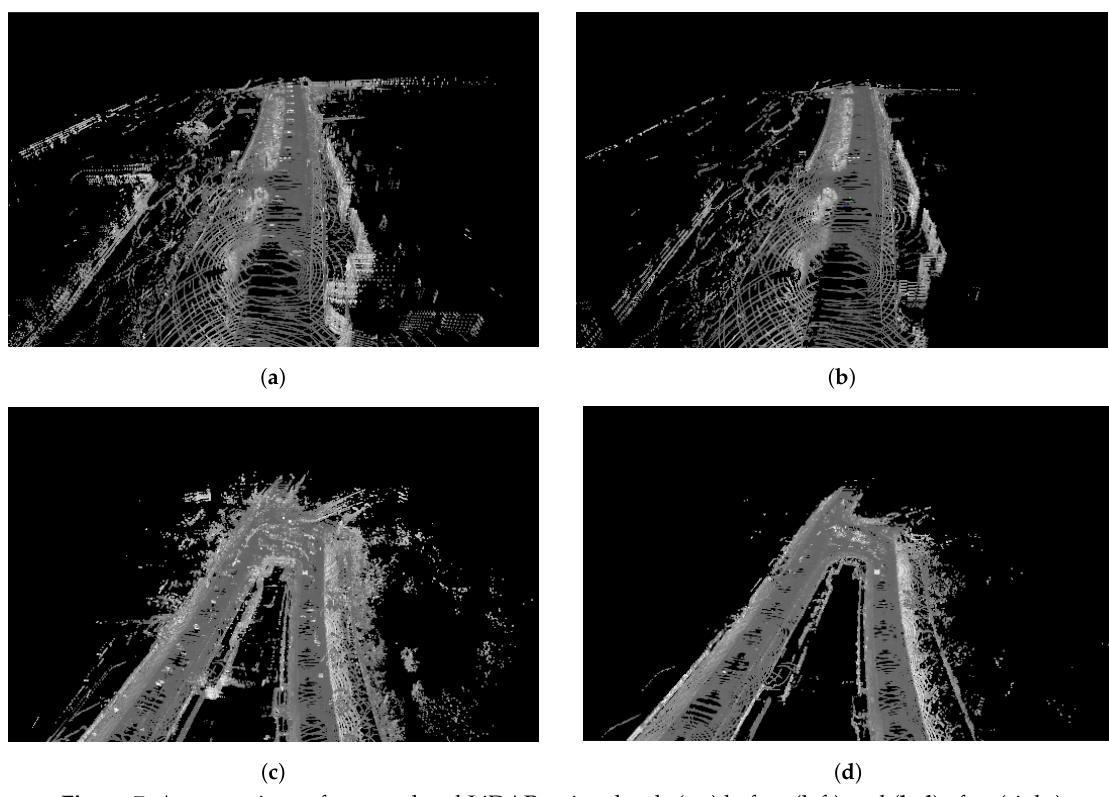
Figure 7. A comparison of accumulated LiDAR point clouds ( a , c ) before (left) and ( b , d ) after (right) removal of duplicate dynamic obstacles from a dense point cloud accumulated over examples take from ( a , c ) straight and ( b , d ) curved road sections. In both cases duplicate cars are removed from the road and there is a reduction in erroneous